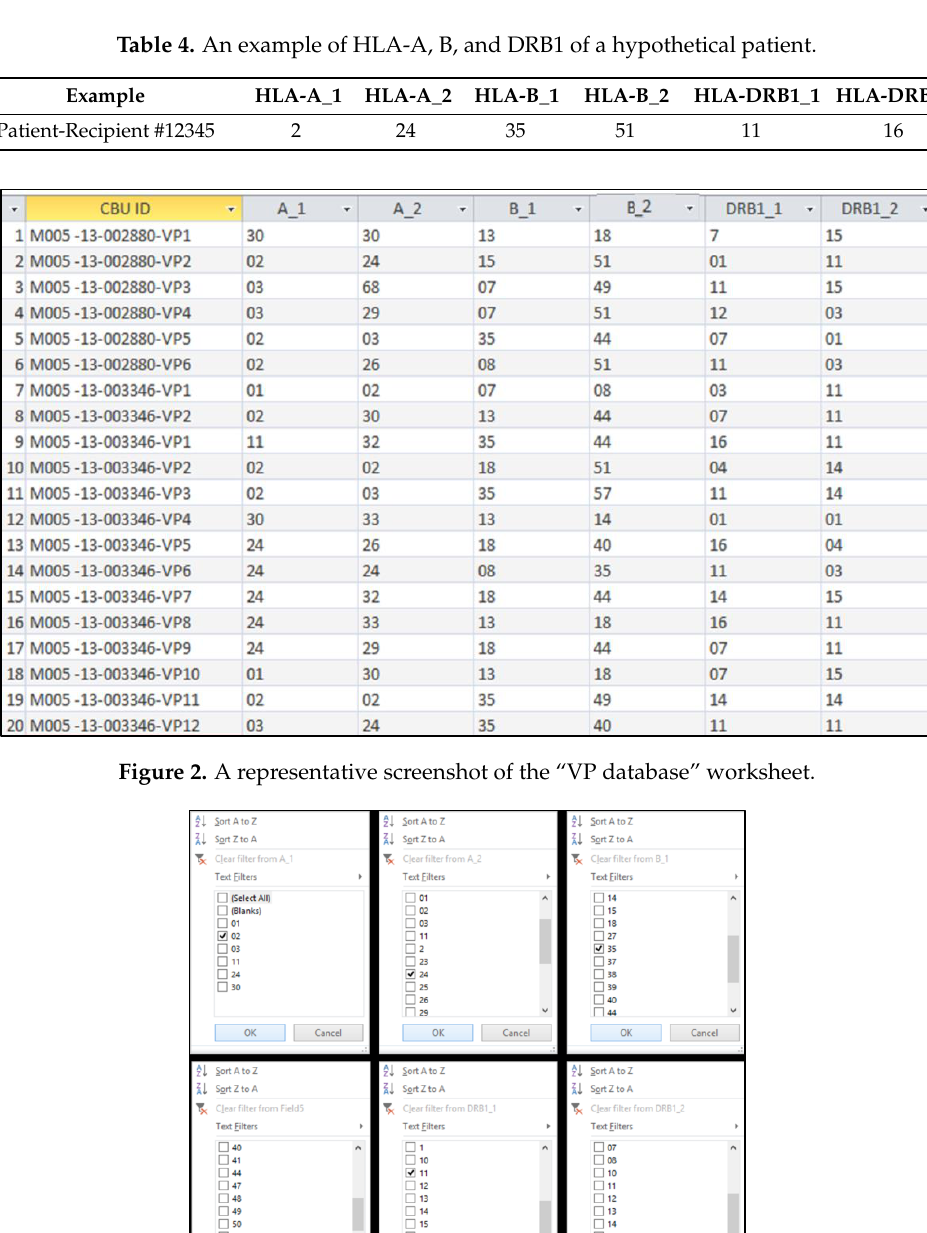
Table 4. An example of HLA-A, B, and DRB1 of a hypothetical patient.